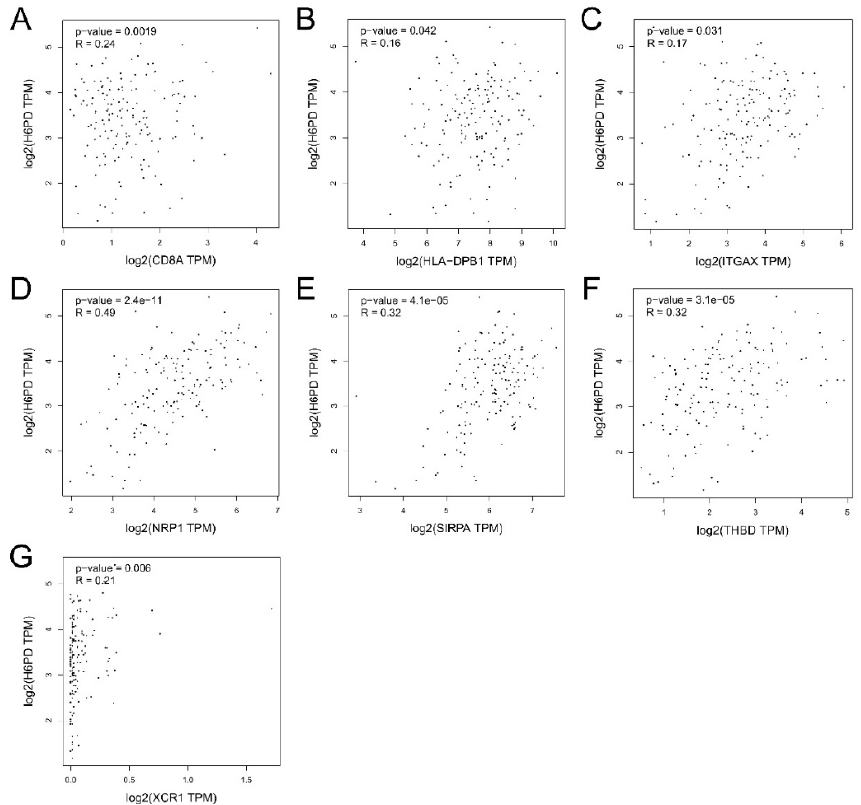
Figure 5. Correlation between biomarkers of dendritic cells and H6PD in GBM. CD8A, HLA-DPB1, TGAX, NRP1, SIRPA, THBD, and XCR1 were positively associated with H6PD expression ( A – G ). Table 1. Correlation between biomarkers of dendritic cells and H6PD in